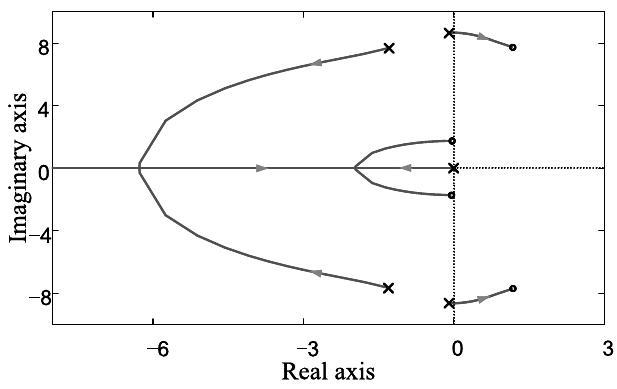
Figure 18. The root locus of D (s) following n 1 changes when n 2 = 0.004 V/var.